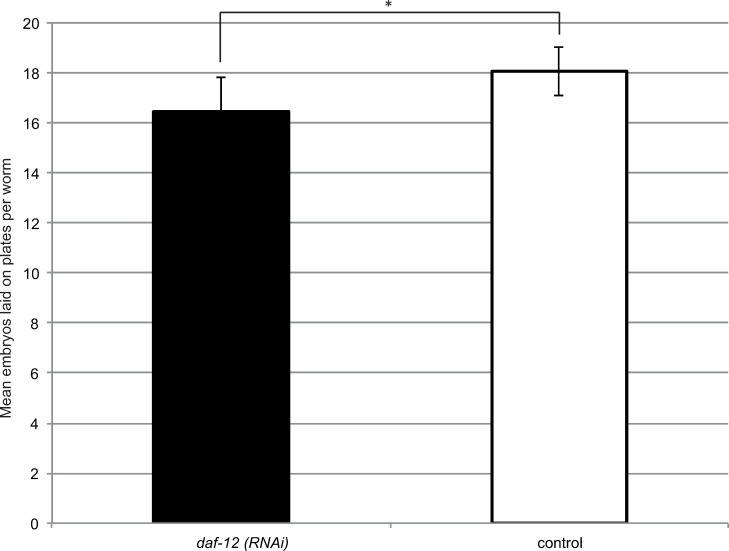
daf-12(RNAi) free-living adults lay slightly but significantly less embryos than control adults.Following soaking (“Late-stage” protocol) with either a scrambled siRNA (control) or daf-12 targeting siRNA (daf-12(RNAi)), free living adults were recovered on plates and the number of embryos they laid counted. Error bars represent standard deviation. This experiment was repeated three times. The bars represent a mean calculated from all three biological replicates. Student’s t-test was performed to determine statistical significance. * indicates a statistically significant p-value between 0.01 and 0.001 (p = 0.004).